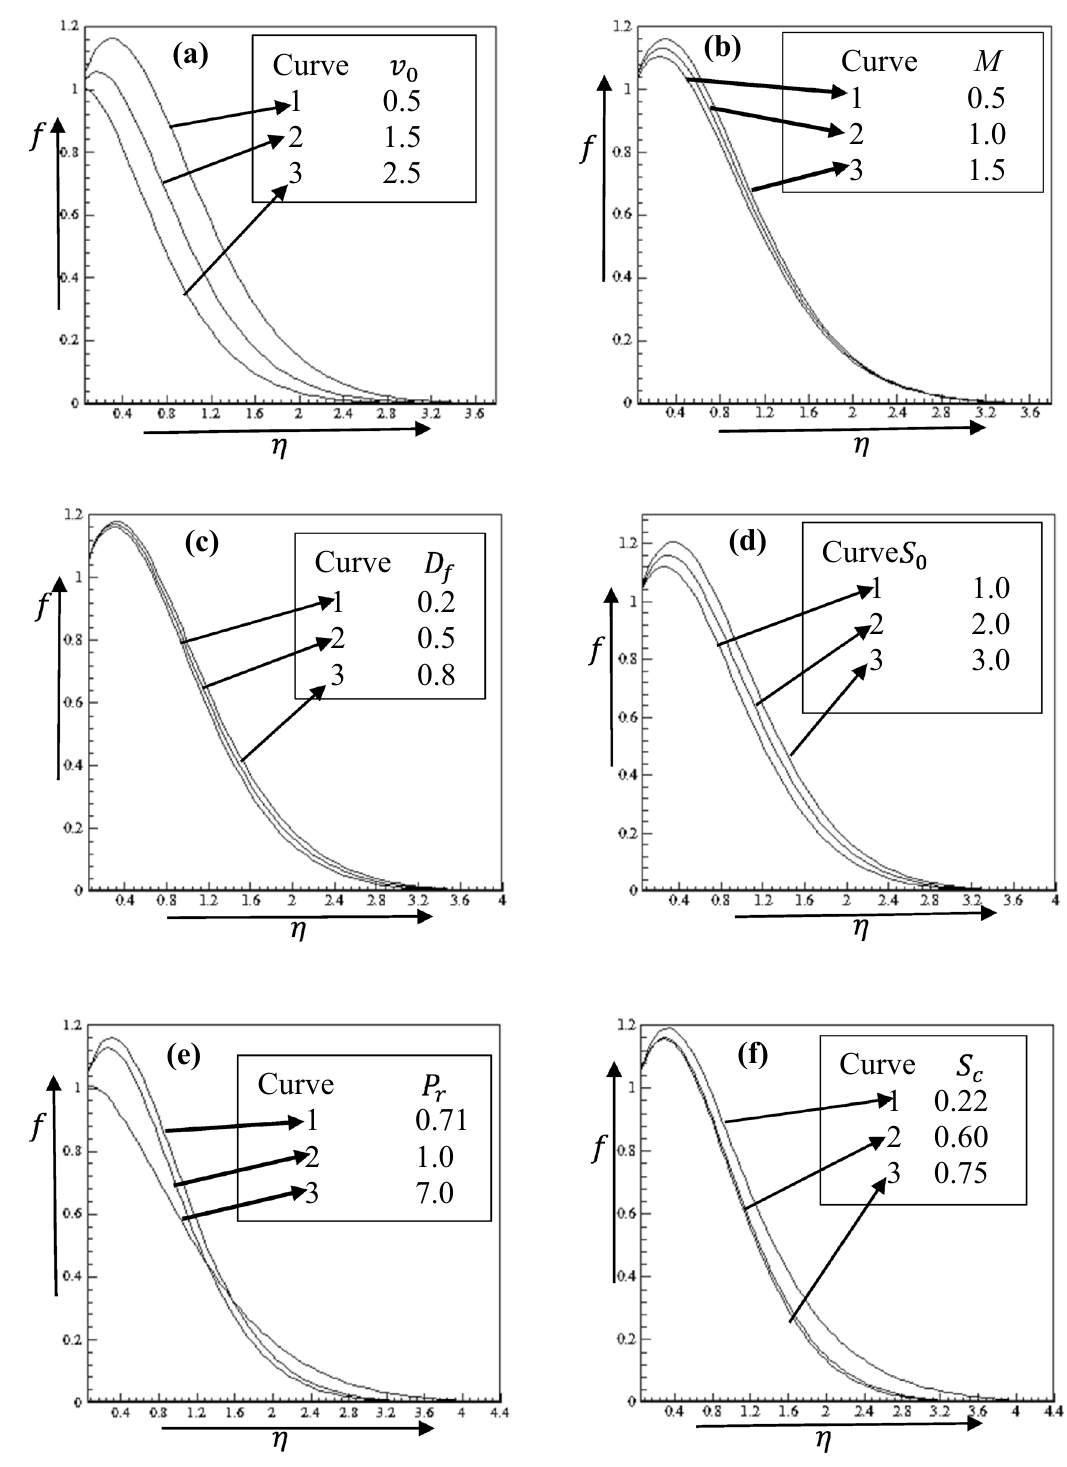
Fig. 2 Velocity profiles for the variation of a v 0 , b M , c D f , d S 0 , e P r , and f S